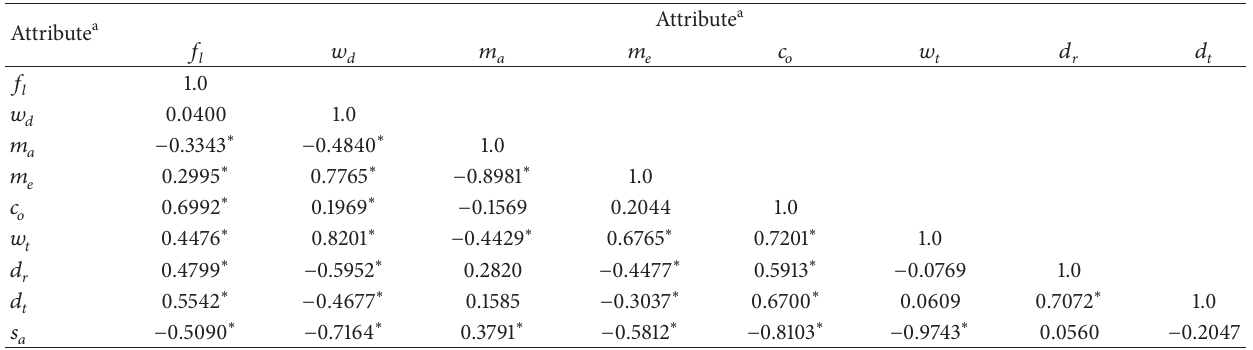
Table 4: Bivariate linear association among fibre attribute values at midrotation as measured by the Pearson product moment correlation coefficient.